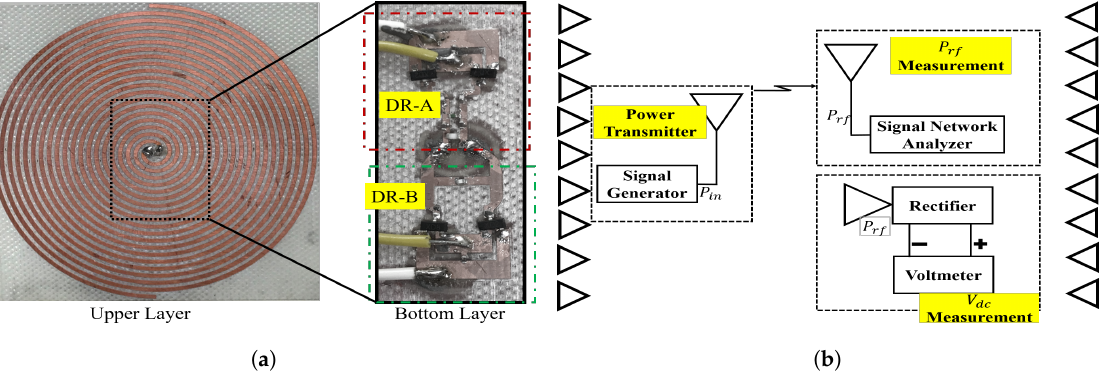
Figure 8. Photograph of the fabricated rectenna prototype and measurement setup, ( a ) Rectenna prototype showing both the upper layer (antenna) and bottom layer (rectifier); the rectifier is combined with two circuits DR-A and DR-B. ( b ) Measurement set-up with an antenna to determine the expected received power.